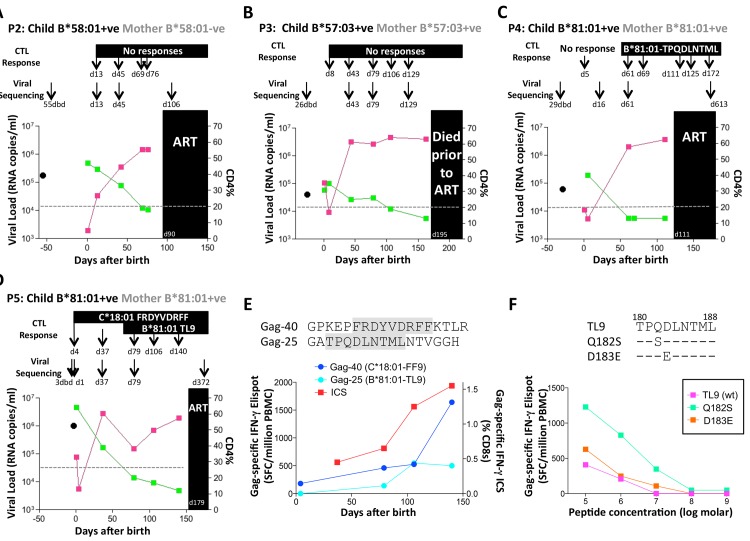
Rapid progression and lack of CTL escape in 4 additional rapid progressor expressing protective HLA-B*57/58:01/81:01.A-D. Clinical data for subjects P2-P5 (as for P1 in Fig 7A). E. In child P5, elispot IFN-γ responses to 17–18mer Gag peptides Gag-40 (from day 4 of life) and Gag-25 (from day 79 of life) and Gag ICS responses to the pool of 66 Gag overlapping peptides. F. In child P5, recognition in IFN-γ elispot assays of autologous TL9 variants TPSDLNTML (Q182S) and TPSELNTML (D183E), compared to recognition of wildtype TL9. PBMC were tested at day 79 and day 141, with the pattern; data are shown from PBMC at day 141.